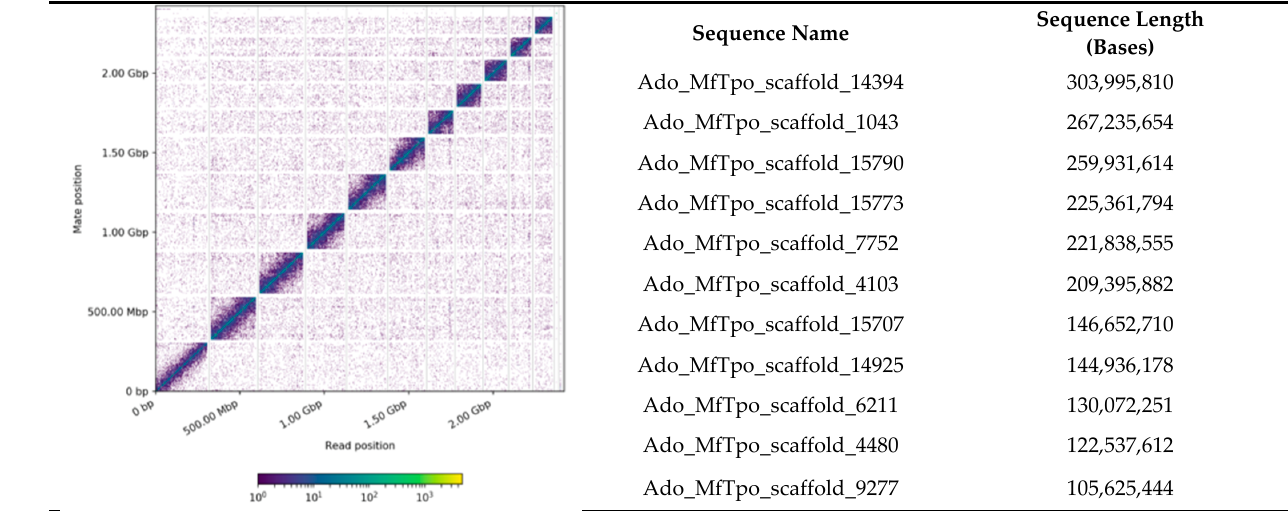
Figure 1. Link density histogram of the A. domesticus Hi-C scaffolded assembly ( left ) and scaffold name and length of the 11 largest scaffolds in the assembly ( right ).